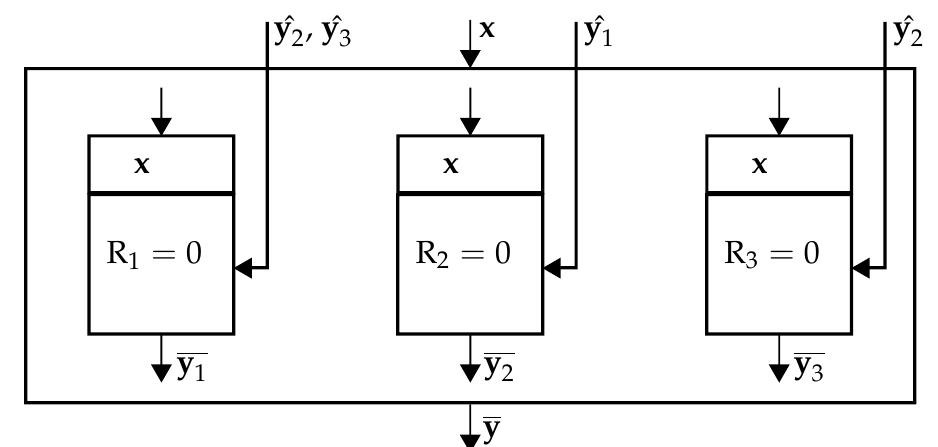
Figure 9. Flowchart of the individual discipline feasibility architecture: detail of the analysis block from Figure 6.